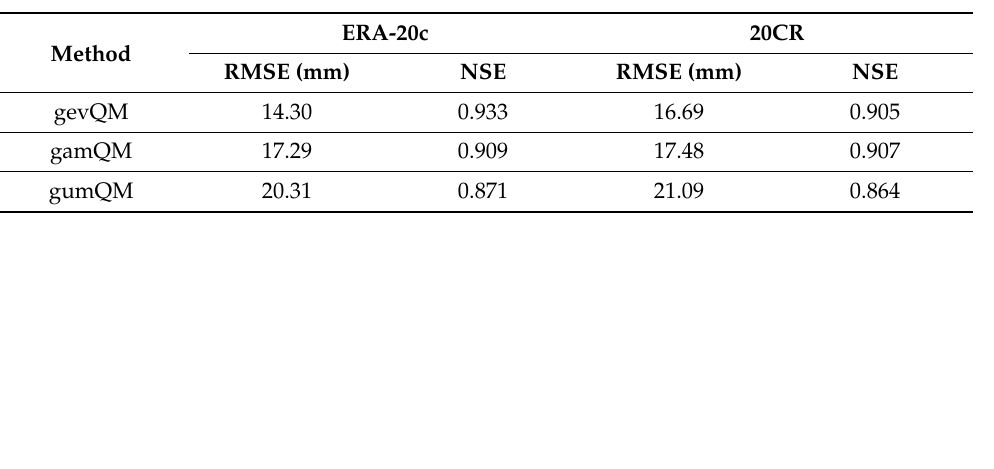
Figure 4. Mapping Nash–Sutcliffe efficiency (NSE) for the AMRs of the bias corrected ERA-20c (above) and 20CR (bottom) by QM approach (gevQM) in 48 stations for the reference period (1974–2010). Table 3. Mean of error estimation results (RMSE (mm) and NSE) for the AMRs of the bias-corrected ERA-20c and 20CR by the QM approaches with GEV, gamma and Gumbel distributions (gevQM, gamQM and gumQM) in 48 stations from 1974 to